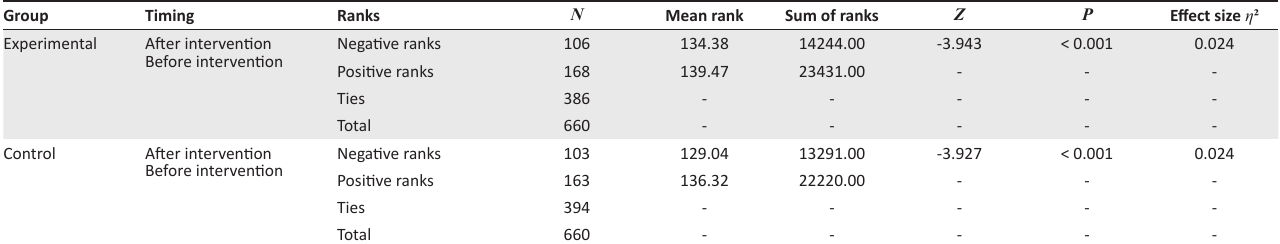
TABLE 4: Wilcoxon ranks table.